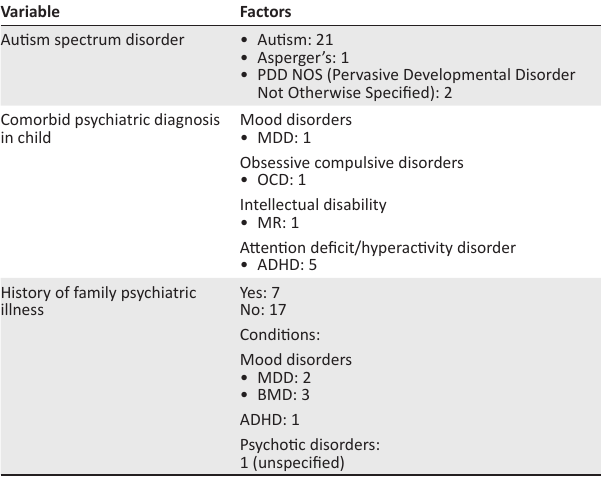
TABLE 5: Clinical